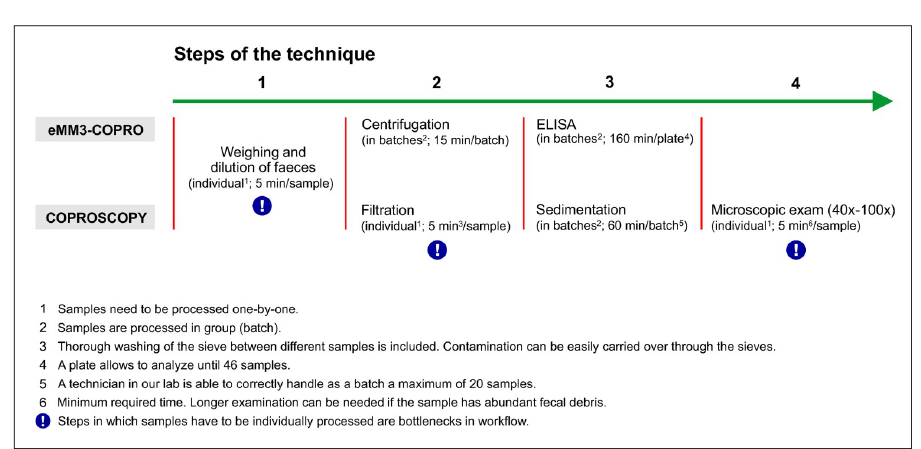
Fig 7. Operational characteristics of eMM3-COPRO test versus